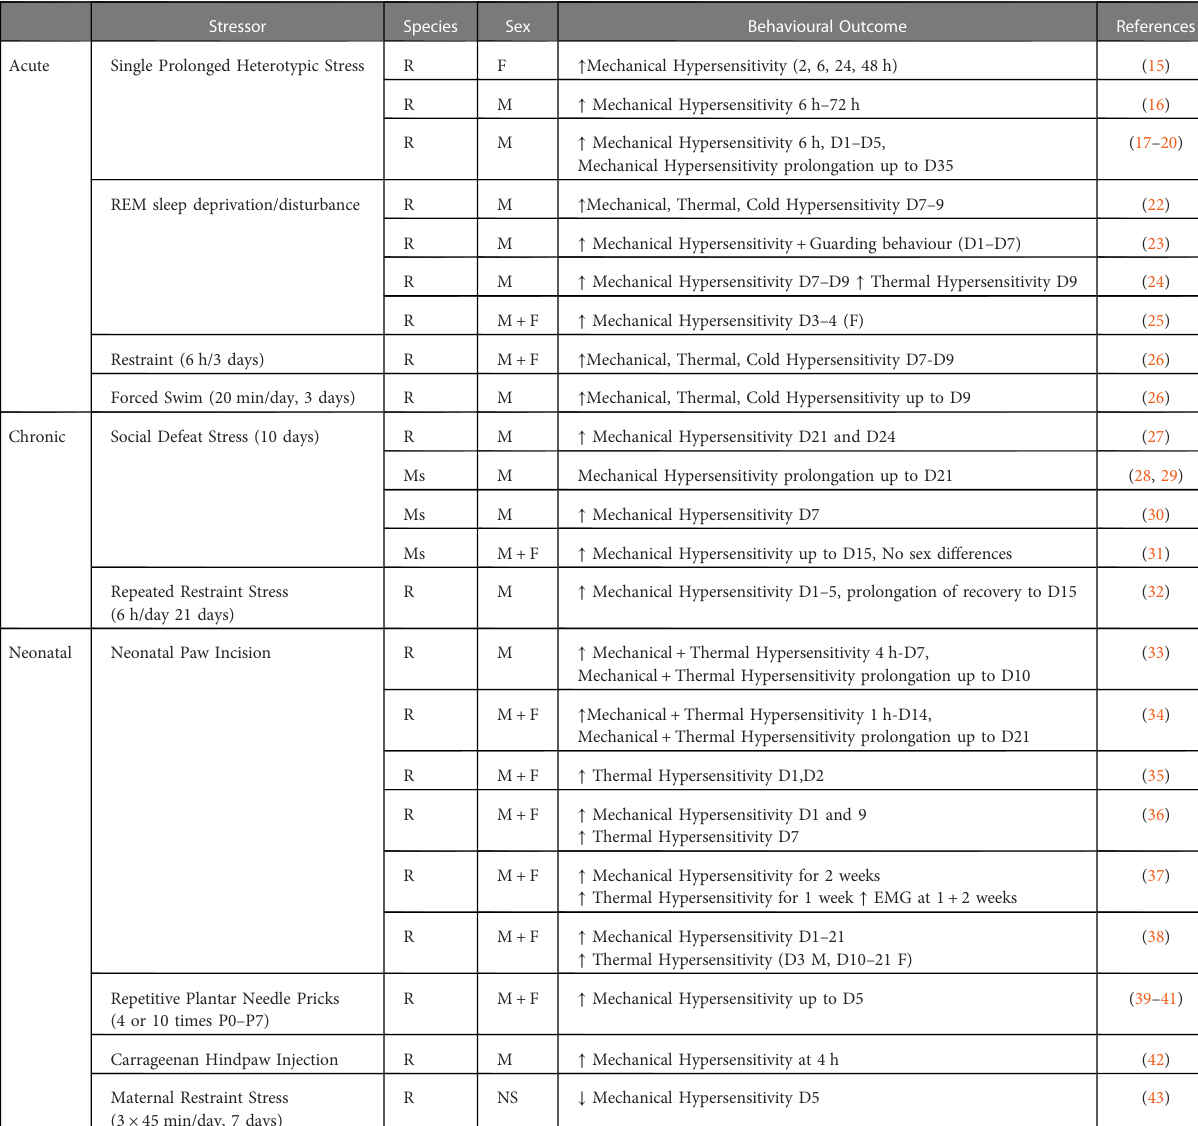
TABLE 1 The effect of stress on nociceptive responding post paw-incision